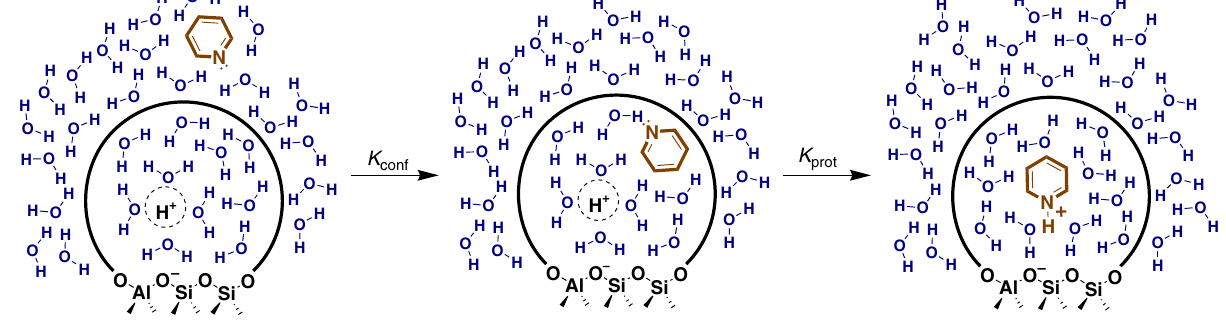
Fig. 5 Depiction of the con fi nement ( K conf ) and the protonation ( K prot ) thermodynamic steps. Pyridine enters the catalyst pore with an equilibrium constant of K conf before being protonated by the BAS with an equilibrium constant of K prot . Solid and dashed curved lines indicate zeolite pores walls and the BAS solvation sphere, respectively.